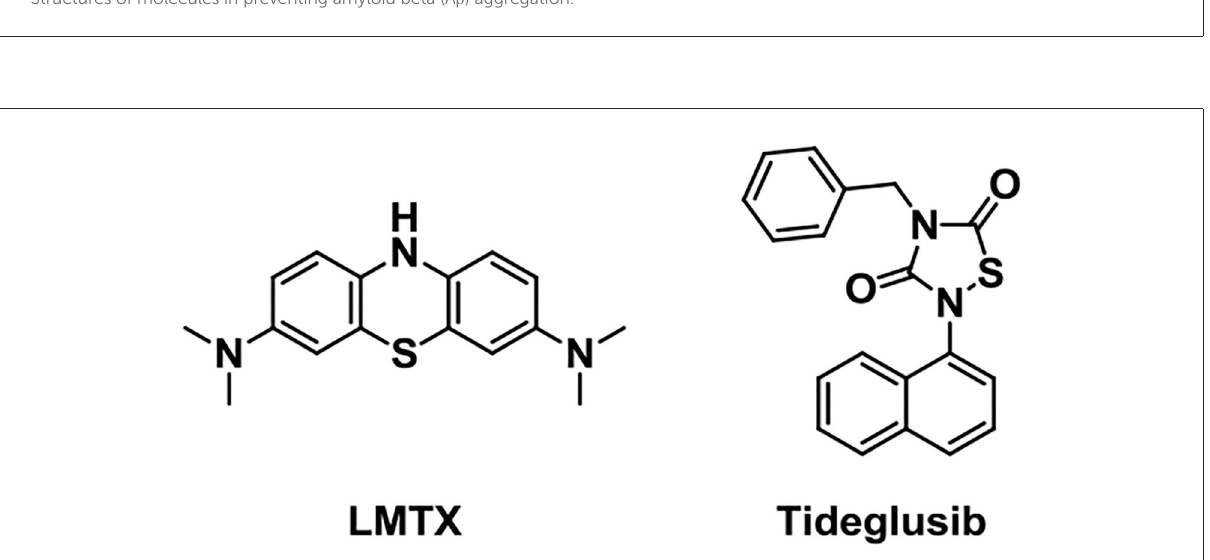
FIGURE9 Structures of tau aggregation